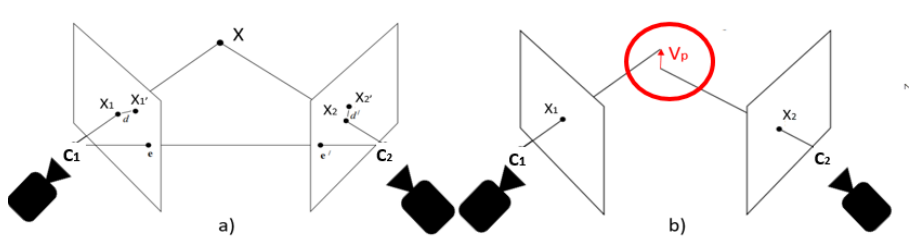
Figure 6. ( a ) An ideal triangulation where C 1 and C 2 define the 3D positions of Cameras 1 and 2, respectively. The 3D Triangulation of point X is projected into two camera views in the points x 1 and x 2 , ( b ) V p is the line segment representing the shortest distance between to two back-projected